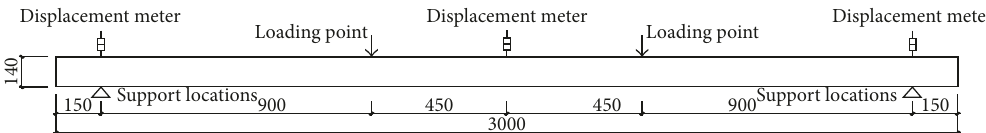
Figure 11: Arrangement of displacement transducer